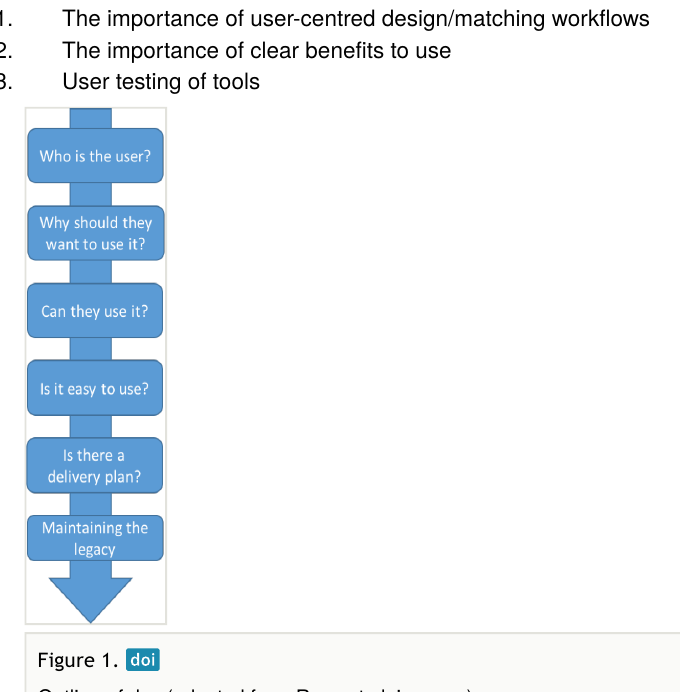
Outline of day (adapted from Rose et al. in